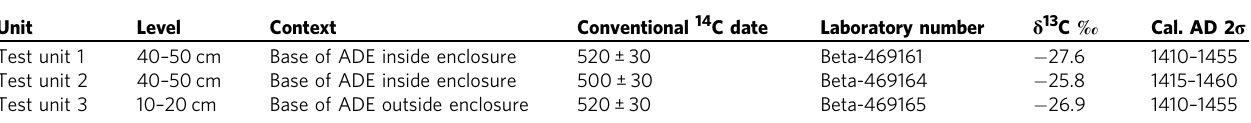
Fig. 4 Distribution of ditched enclosures in the surveyed area of the UTB. Another four sites have been recorded ~150 – 200 km to the west and east and are not shown. Small circles are buffers of ~25 km, corresponding to the territory of medium and large sites based on the average distance between them. The large circles around the major centres are buffers of ~85 km based on the average distance between sites of this class. Dashed circles highlight the potential western and eastern regional site systems. Background landsat imagery from 2017 showing forests (grey) and deforested patches (white). Landsat-7 image courtesy of the U.S. Geological Survey. For location of the study area in southern Amazonia, see red box in Fig. 1 Table 1 Radiocarbon dates from site